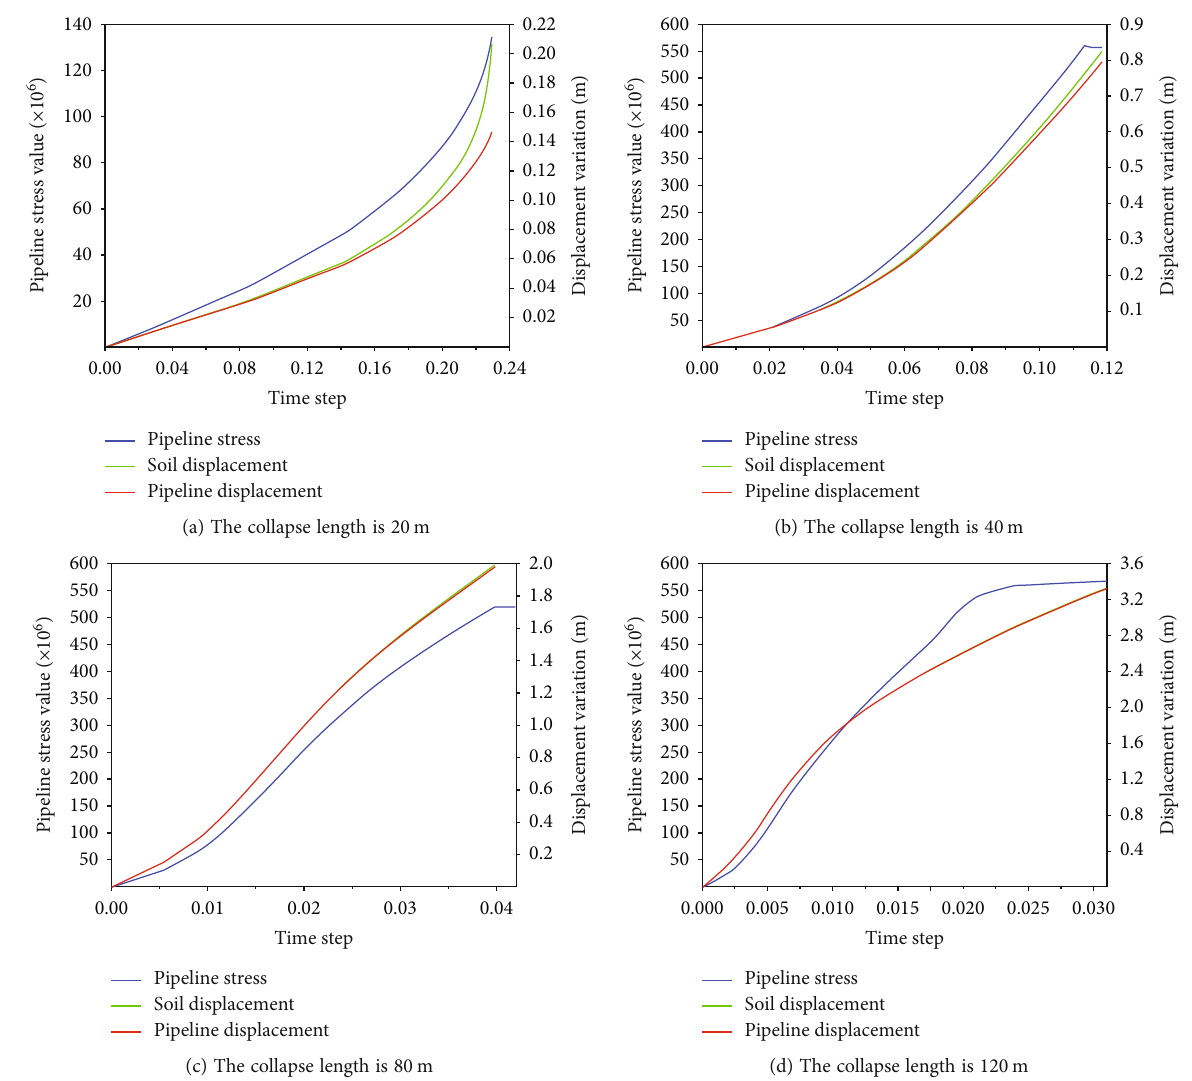
Figure 7: The diagrams of pipeline stress, displacement, and soil displacement under di ff erent collapse